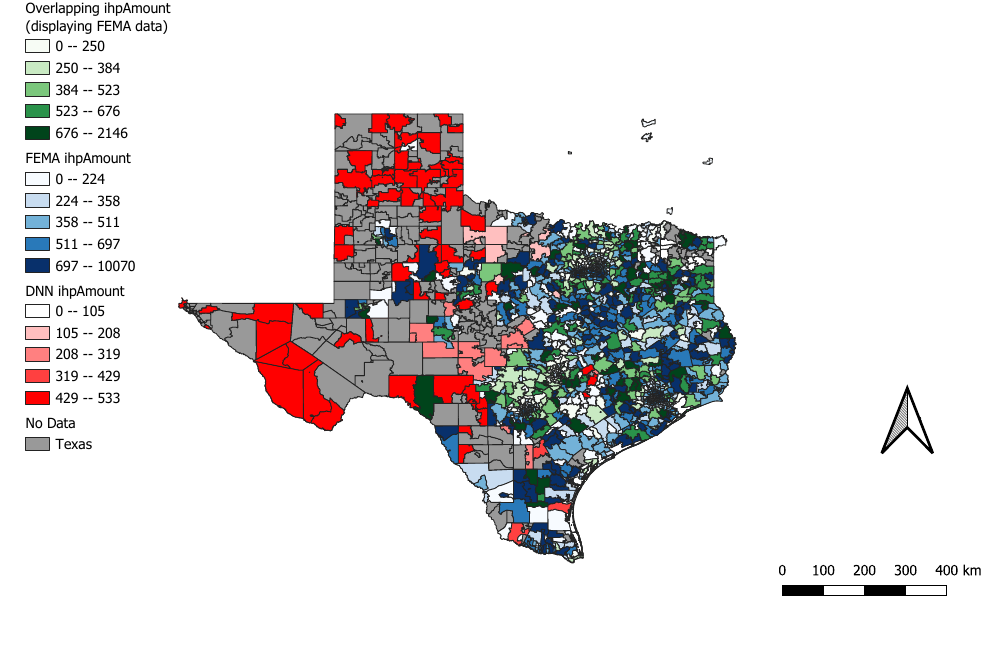
Figure 4. Distribution of ihpAmount ($) from FEMA, and the DNN model prediction. In order to evaluate the damage prediction accuracy across geographies, Figure 5 displays the ihpAmount prediction error for each paired zip code, i.e., green in Figure 4. The error percentage is calculated by Equation (5) for each zip code, where damage true is the FEMA ihpAmount and damage predict means the DNN predicted value. According to this definition, the lower the error (coded with lighter color), the closer the prediction is to the FEMA survey, and the darker the color, the less accurate for the DNN estimation. The color intensity is divided into 10 equal bins by data size, with the remaining marked in light